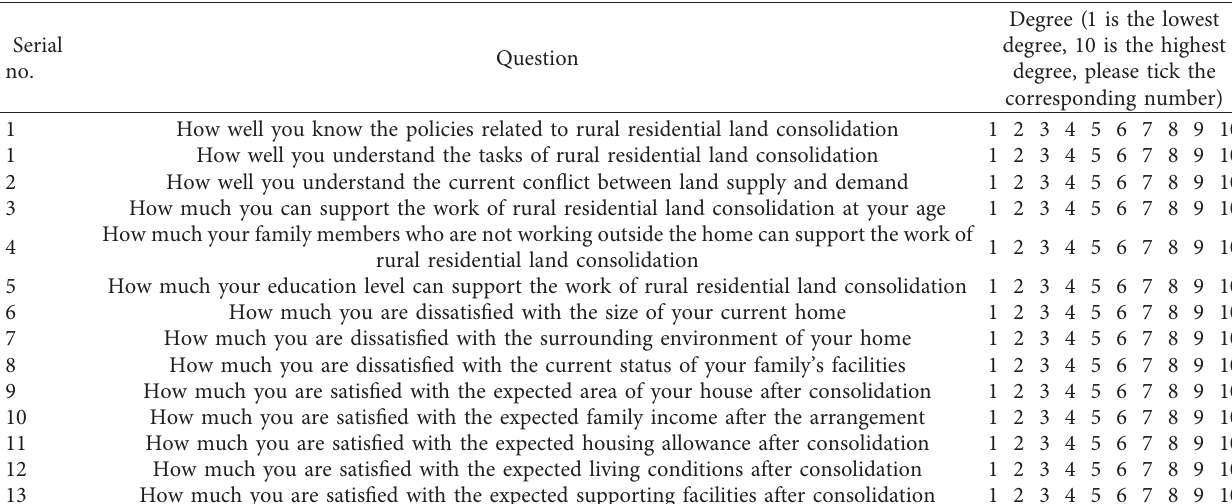
Table 11: Farmers’ willingness questionnaire in rural residential land consolidation potential estimation.